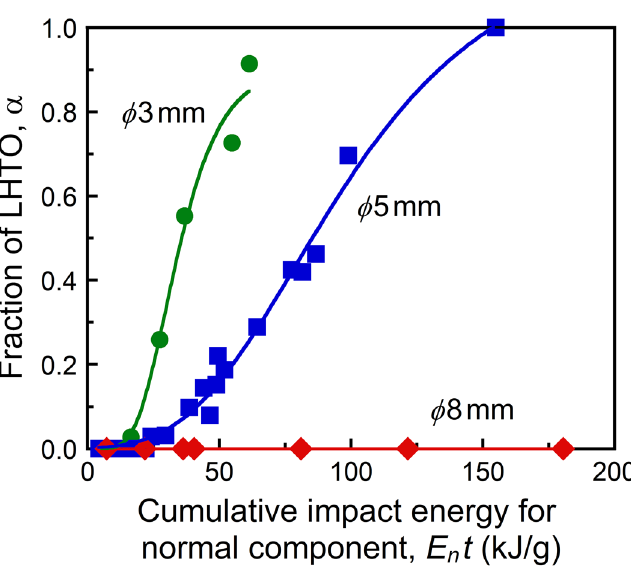
Figure 4. Effect of E n t on the formation fraction of LHTO through wet mechanochemical